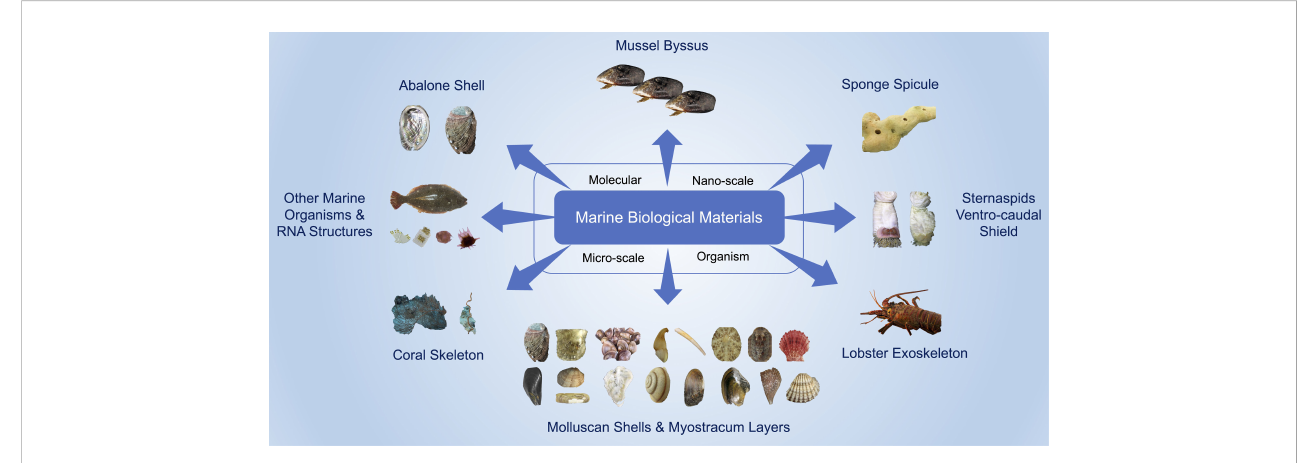
FIGURE 1 Marine organisms and biological materials investigated in this Research